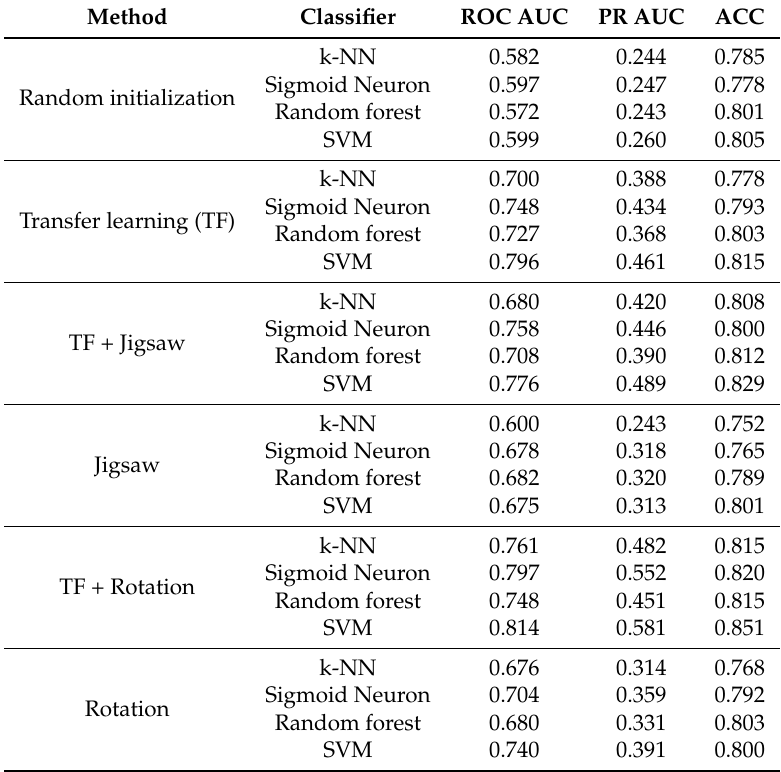
Table 2. The evaluation of the quality of extracted image